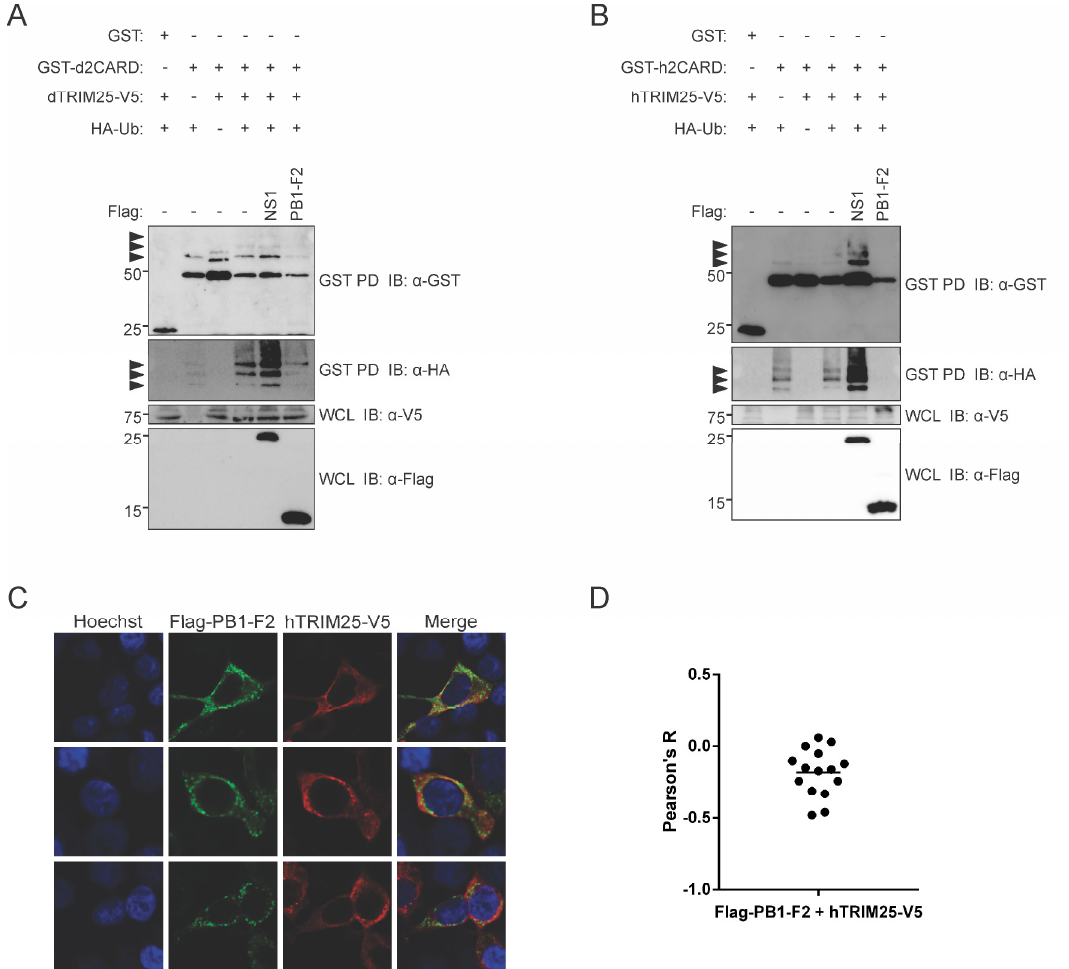
Figure 5. PB1-F2 inhibits TRIM25-mediated RIG-I-CARD ubiquitination. ( A ) DF-1 cells were transfected with GST-tagged duck RIG-I CARD domains (GST-d2CARD) or empty GST vector, together with V5-tagged duck TRIM25 (dTRIM25-V5), HA-tagged ubiquitin (HA-Ub), and the indicated Flag-tagged proteins (NS1 or PB1-F2). 24 h post-transfection, clarified whole cell lysates (WCL) were subjected to GST pulldown (GST PD), followed by immunoblotting (IB) with anti-GST, anti-HA, anti-V5, and anti-Flag antibodies. Arrowheads indicate ubiquitinated bands. ( B ) HEK293T cells were transfected with GST-tagged human RIG-I CARD domains (GST-h2CARD) or empty GST vector, together with V5-tagged human TRIM25 (hTRIM25-V5), HA-tagged ubiquitin (HA-Ub), and the indicated Flag-tagged proteins (NS1 or PB1-F2). GST pulldown and immunoblotting were performed as above ( C ) PR8 PB1-F2 localizes to cytoplasmic puncta that partially exclude human TRIM25. HEK293T cells overexpressing hTRIM25-V5 and Flag-PR8-PB1-F2 proteins were fixed, stained, and imaged using confocal microscopy. Panels show staining with Hoechst 33324 (nuclei, blue), anti-Flag antibodies (green), anti-V5 antibodies (red), and a merged image. Original magnification X1000. ( D ) Co-localization of Flag-PR8-PB1-F2 with hTRIM25-V5 was quantified using Pearson’s correlation coefficient (Pearson’s R). Bar shows mean value from 15 analyzed cells.